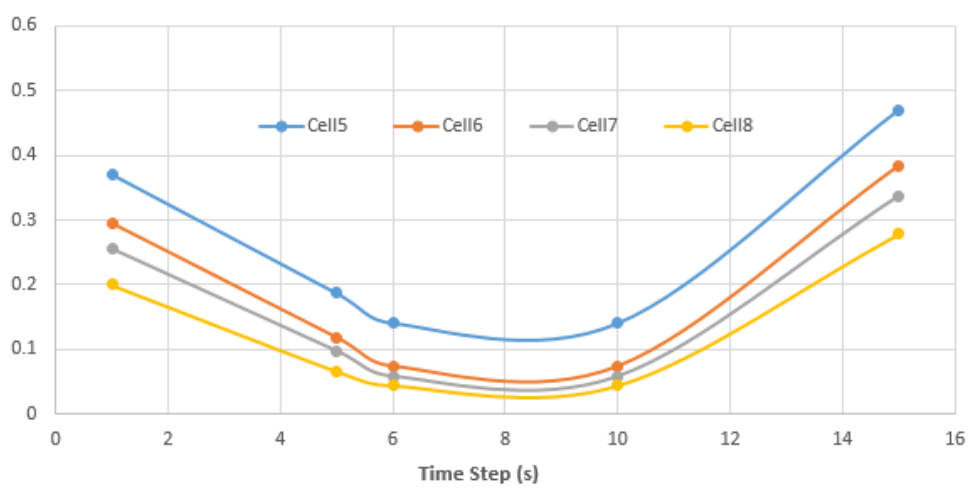
Figure 5. Change in the maximum flood depth value (Cells 5–8) for different time steps in sub-reach K6.